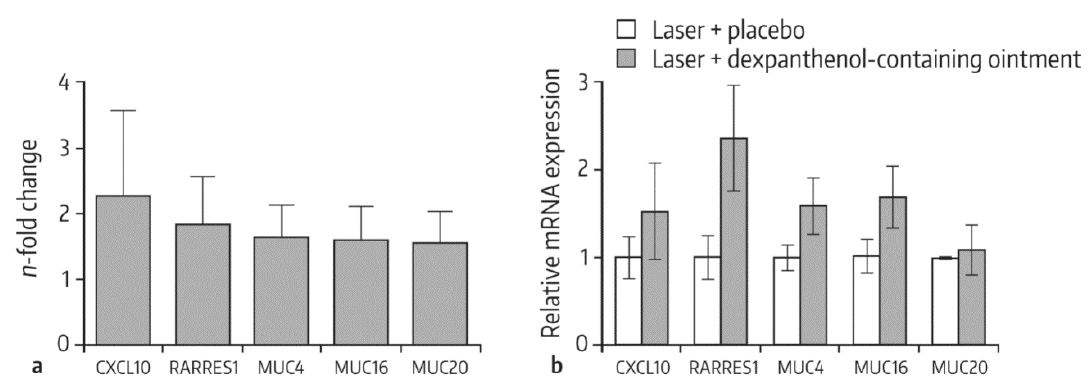
Figure 1. Gene expression profiling in 3D mucous membrane models after laser injury and treatment with a dexpanthenol-containing ointment in comparison with the placebo-treated control. ( a ) 3D mucous membrane models were harvested 3 days after laser treatment (100 mJ/cm 2 ), and gene expression was measured using the Affymetrix ® Gene Chip Human Exon 2.0 ST microarray. Results of 3 experiments were pooled. ( b ) TaqMan real-time polymerase chain reaction (qRT-PCR) analysis of selected genes on day 3 after treatment. Mean values with standard error of the mean (SEM) of 3 independent experiments performed in duplicate are shown. From Ref. [54] with kind permission from S. Karger AG (www.karger.com/SPP).